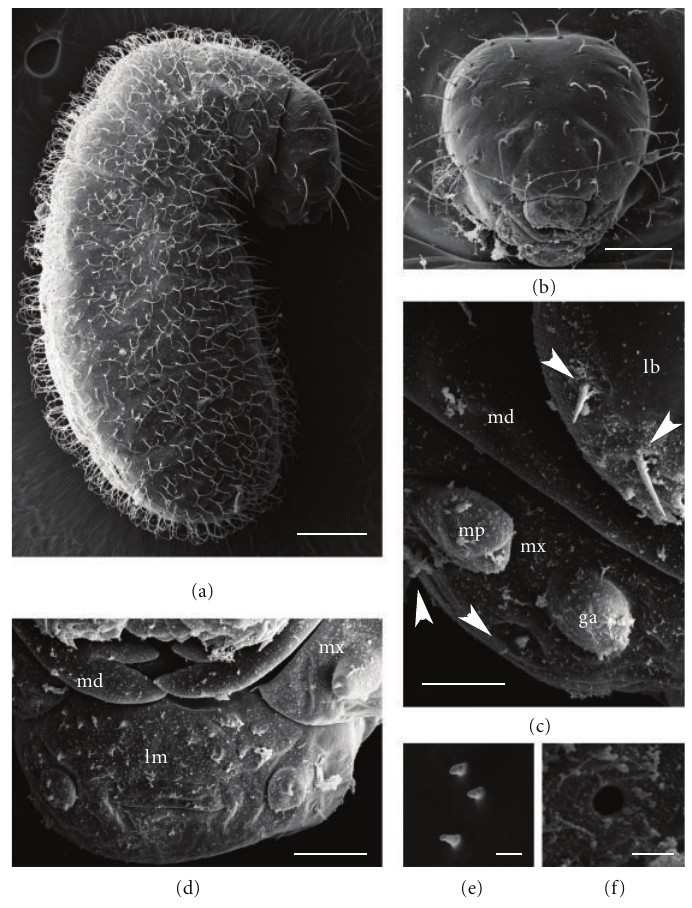
Figure 4: Fourth instar larva of Solenopsis saevissima worker. (a) Larva in side view. (b) Head capsule in full frontal view. (c) Frontal view of right mouthparts; lb: labrum; mx: maxilla; md: mandible; mp: maxillary palp; ga: galea; arrowheads: setaceous sensilla. (d) Lower mouthparts; md: mandibule; mx: maxilla; lm: labium. (e) Antennal sensilla (setaceous). (f) thoracic spiracle. Respective sizes of scale bars ( µ m): 200, 100, 10, 15, 5, and